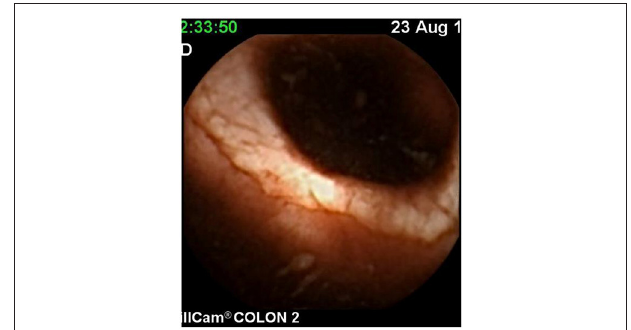
FIGURE 2 | Moderate Crohn’s with superficial and deepening ulcers.